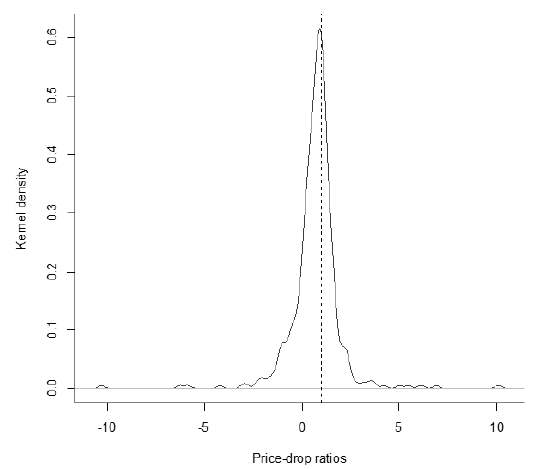
Figure 3. Kernel-density estimate of price-drop-ratio distribution. This figure depicts a kernel-based estimate of the distribution of price-drop ratios (PDRs) based on XETRA closing prices. The PDR is defined as the adjusted drop from closing cum price to closing ex price over the dividend payment of a stock. The sample includes all constituents with tax-free dividends of the German CDAX index between January 2002 and September 2019. Epanechnikov kernel density. Data source: Refinitiv EIKON.